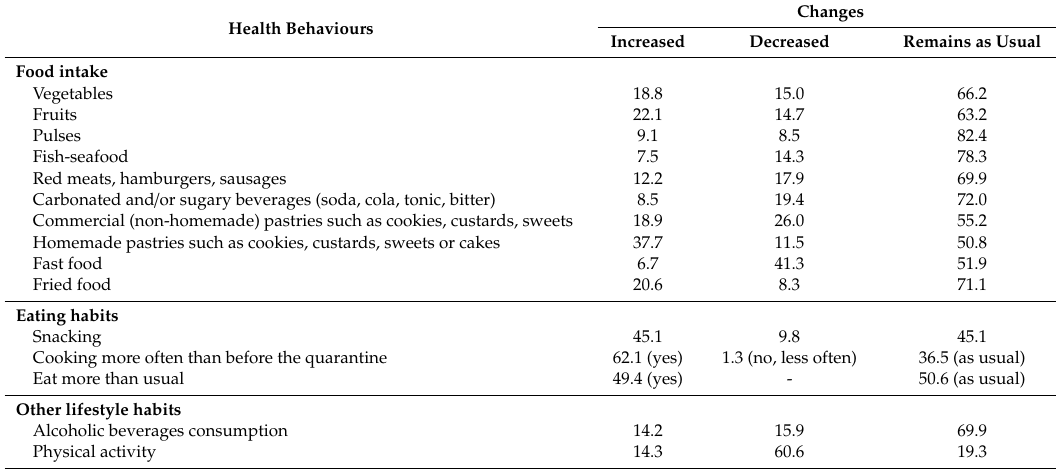
Table 2. Changes in health behaviours during the quarantine (%).